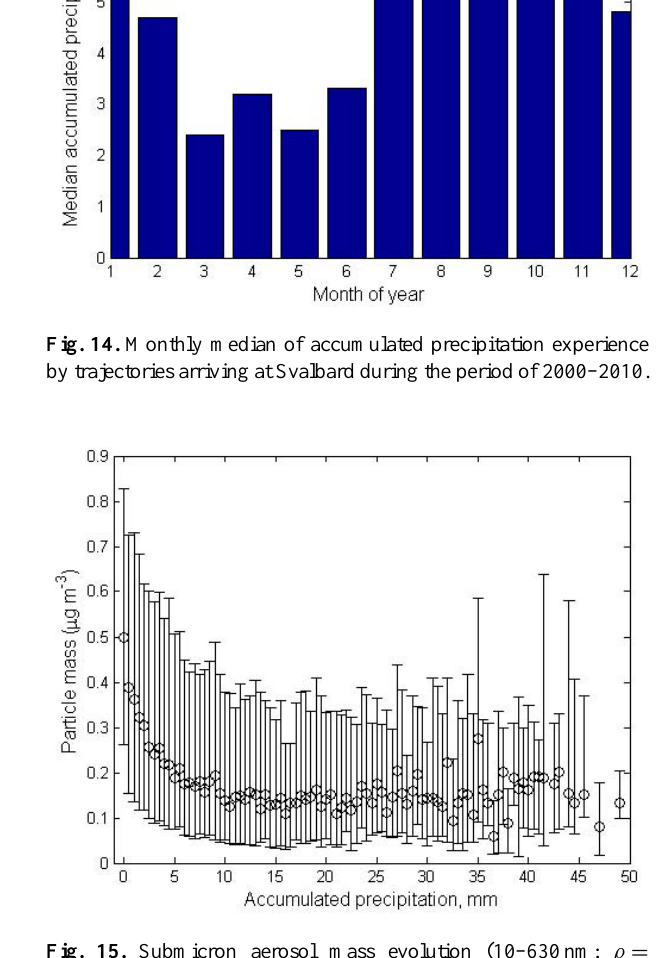
Fig. 15. Submicron aerosol mass evolution (10–630nm; ρ = 1gcm − 3 ) as a function of accumulated precipitation along the tra- jectories. Data are shown as 25–75th percentile ranges per bin (solid lines) and median (circles). The figure includes all data collected between 2000 and